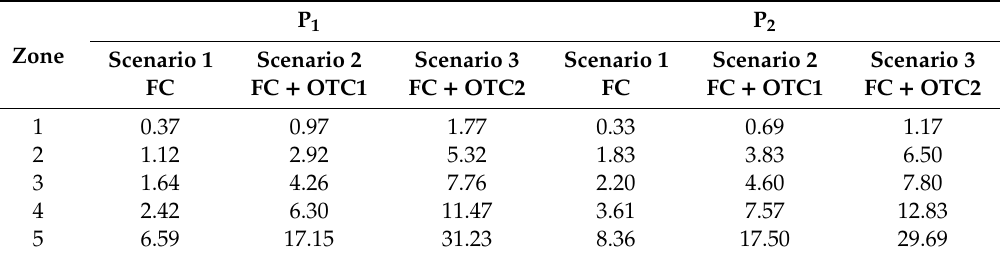
Table 7. Initial demand function points for the SPNP (P 1 and P 2 ).